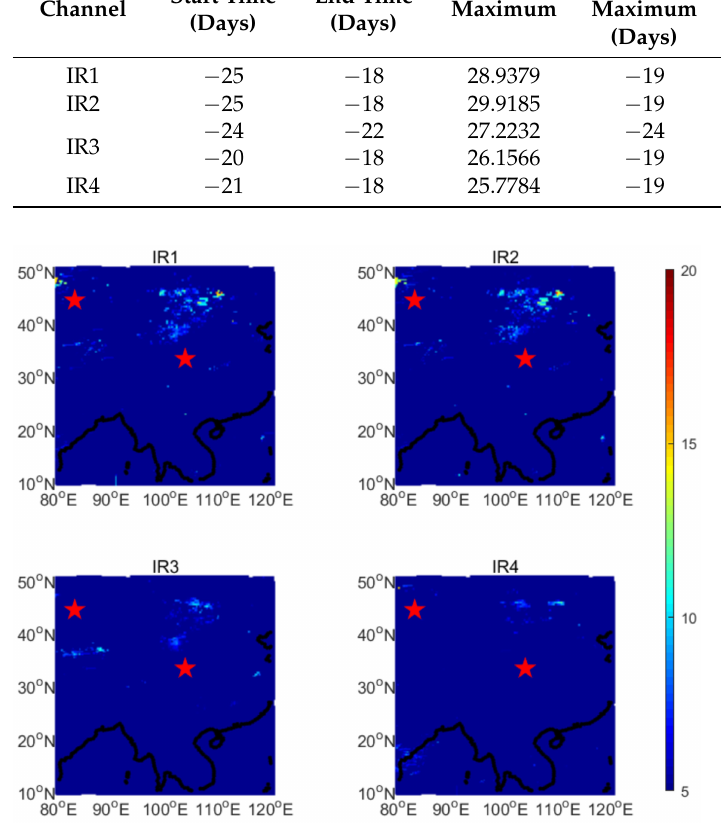
Figure 9. Power spectrum images on 14 July